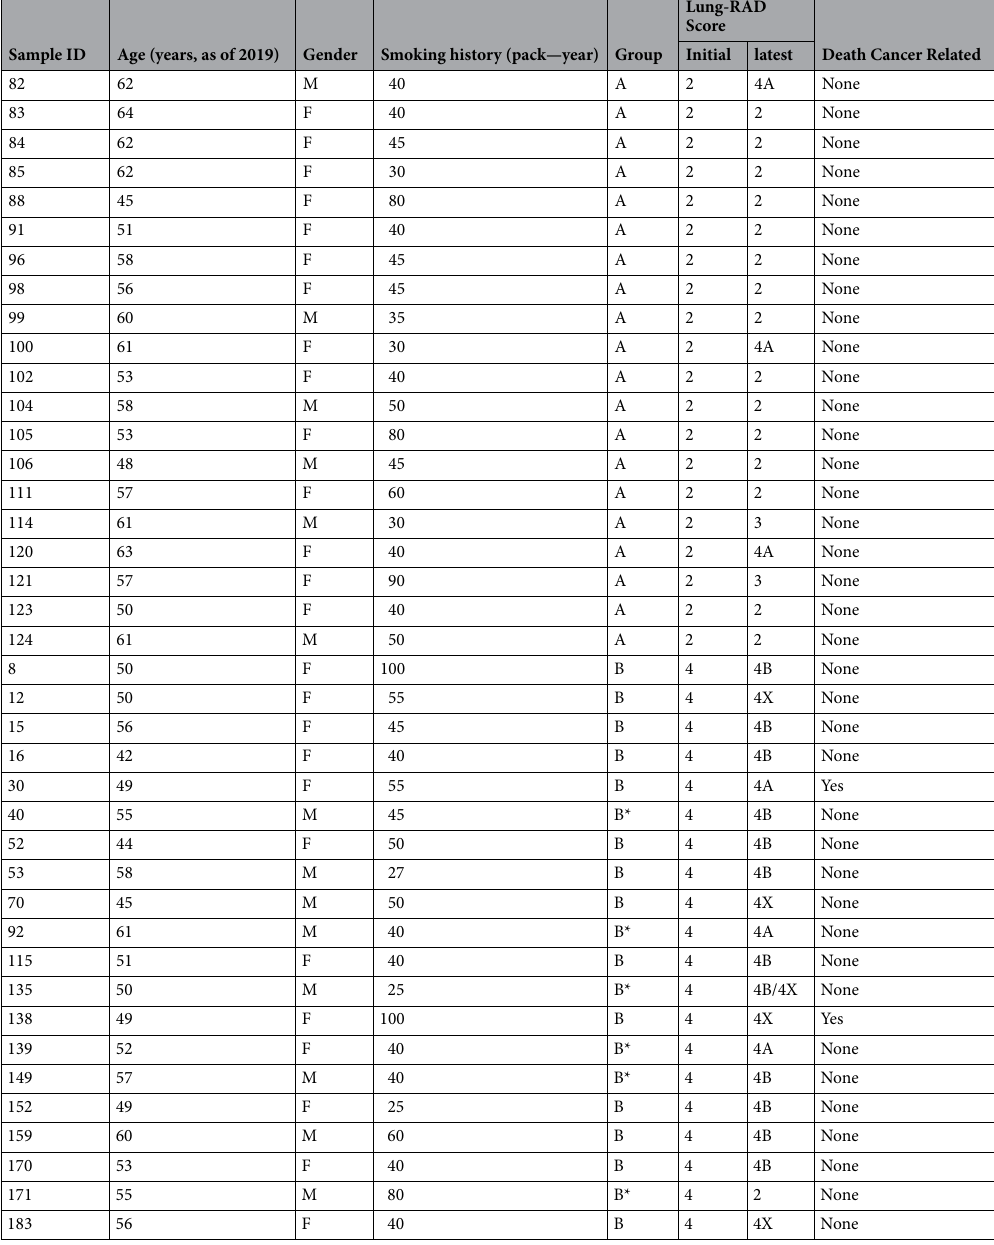
Table 1. Study participants. Table showing each patient’s description including, age, gender, smoking history, and cancer progression status. False positive diagnoses are denoted with an asterisk (*) in the Group column. Group A and B contain individuals with lung-RADS2 or lung-RADS4 initial LDCT findings,